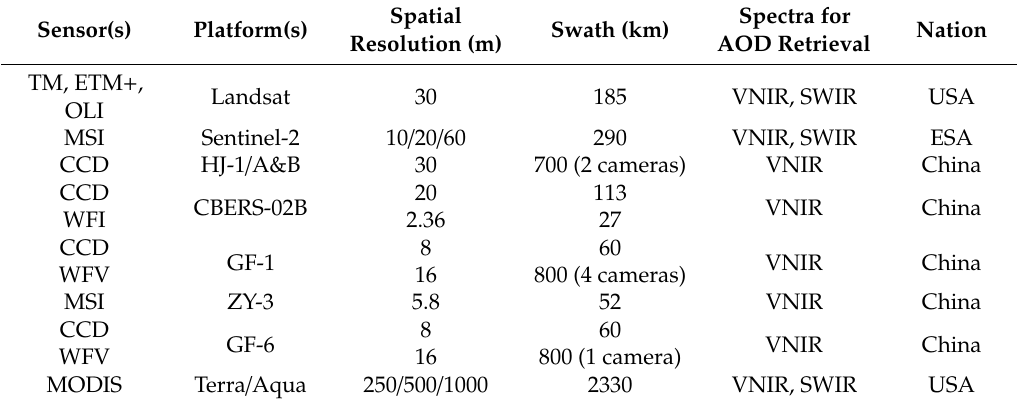
Table 1. The details of the moderate to high spatial-resolution (MHSR) data are used in this study 1 .